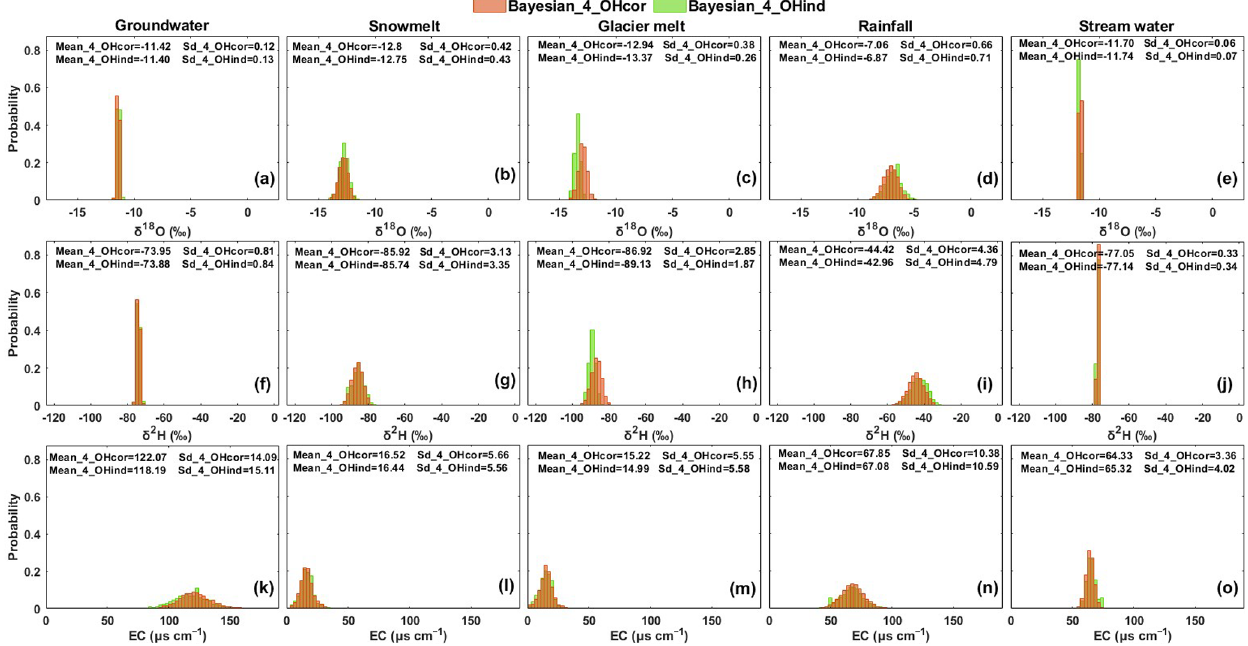
Figure 6. Comparison of the posterior distributions of tracer signatures estimated by the Bayesian approaches with Bayesian_4_OHcor and without Bayesian_4_OHind considering the correlation between δ 18 O and δ 2 H in the glacier melt